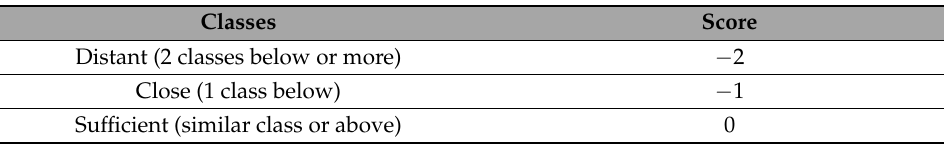
Table 13. TRe ds,pa —temporal resolution. Classes